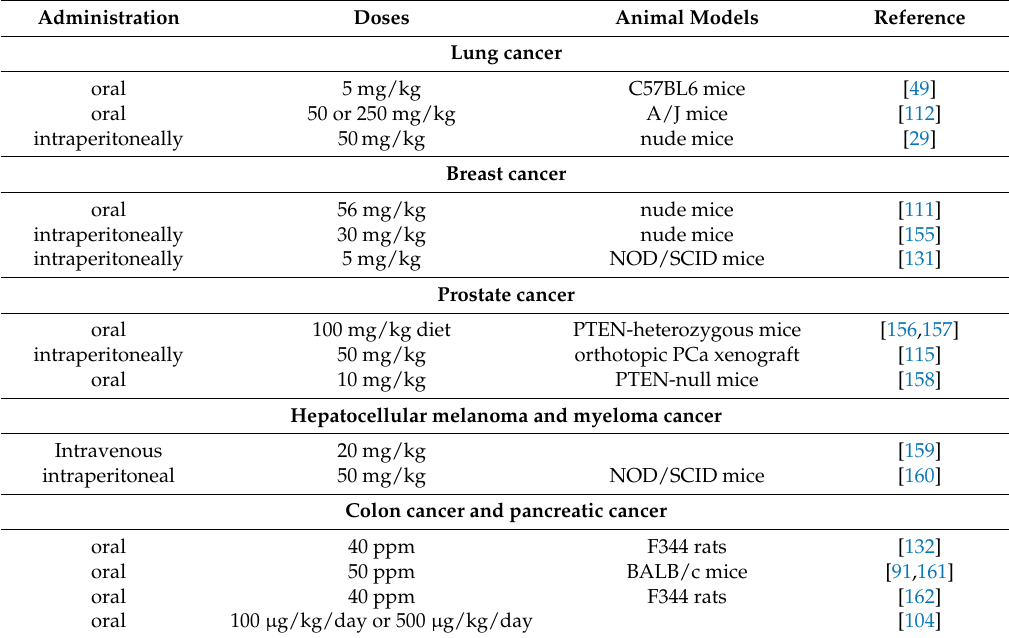
Table 3. Summary of potential prevention and treatment of various types of cancer by